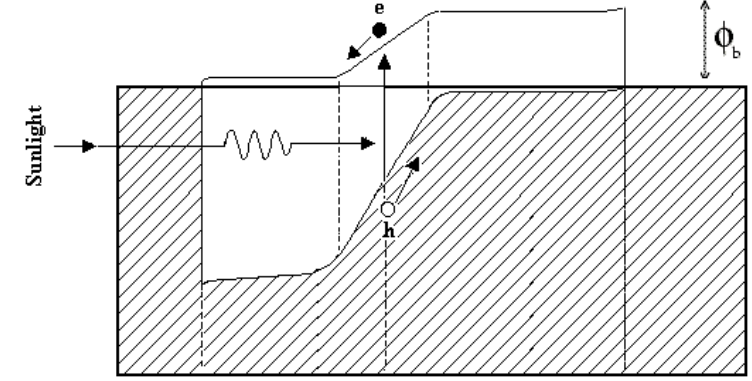
Figure 22. Energy band diagram of a genuine p-n junction formed with CdS and p-type CdTe layers. The p-type dopant containing Au, Cu/Au, Cu/Ni, Sb-compounds and As-containing compounds forms ohmic contacts to the p-CdTe